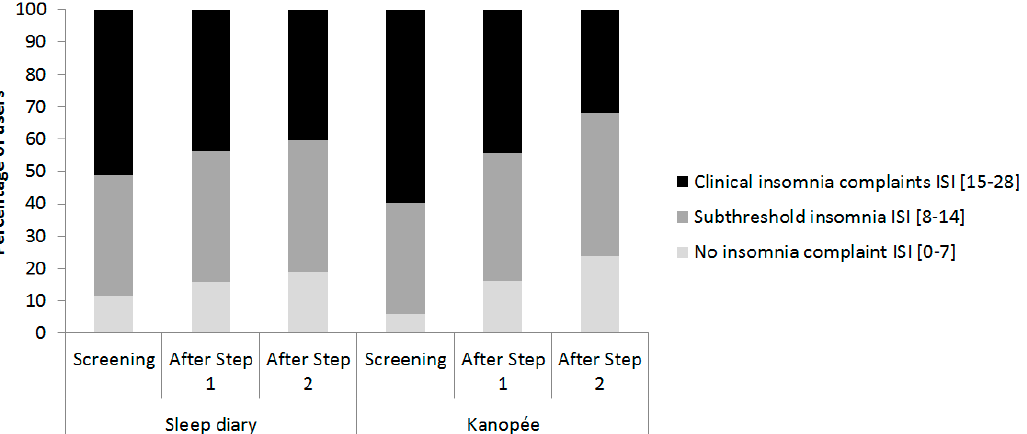
Figure 4. Distribution of sleep diary versus KANOPEE users depending on severity of their insomnia complaints over time.